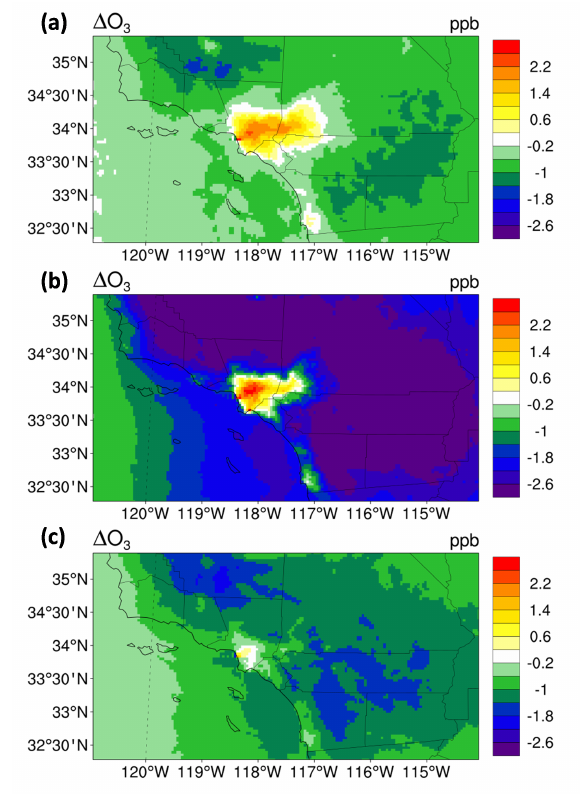
Figure 9. Spatial distribution of the differences in MDA8 O 3 between the three sensitivity scenarios and the Base scenario: (a) VOC1.0 minus Base; (b) NO x 0.3 minus Base; (c) VOC0.3 mi- nus Base. The definitions of all scenarios are summarized in Table